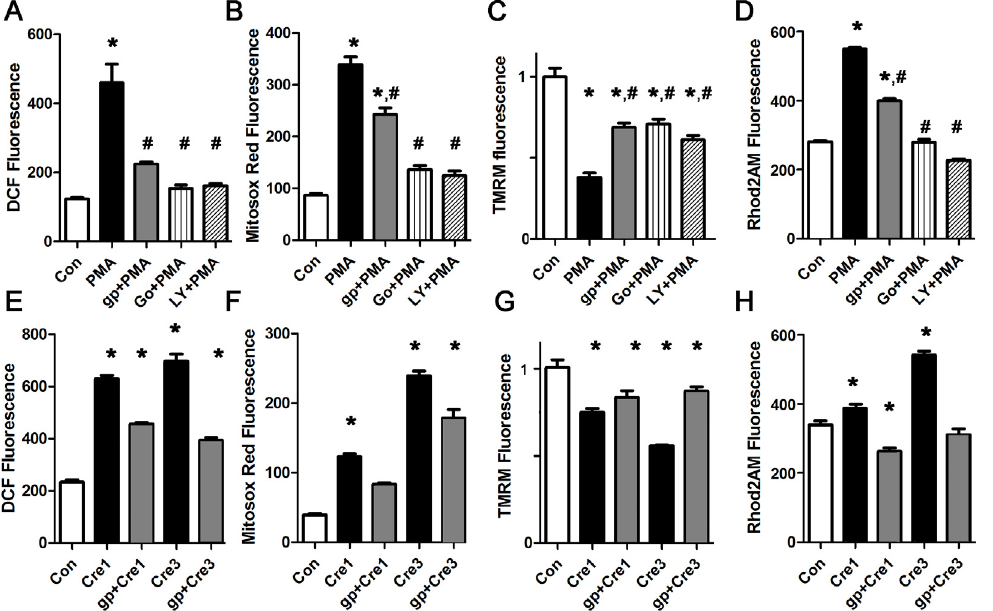
Fig 5. NOX2 inhibition reduces PMA-induced and cresol-induced ROS. A. Representative PMA experiment done with cardiomyocytes in triplicate, height is DCF fluorescence minus background, in live cells, expressed in arbitrary units, mean + SEM. B. PMA experiment using mitosox red signal. C. PMA experiment using TMRM signal. The NOX2 inhibitor and PKC inhibitors reduce depolarization. D. PMA experiment using Rhod2 signal. The NOX2 inhibitor and PKC inhibitors reduce calcium overload. E,F. Cresol increases total ROS and mitochondrial ROS. G. Cresol depolarized the mitochondrial inner membrane. H. Cresol increases mitochondrial calcium. For all panels, means are significantly different by ANOVA, * = sig different from control by post-hoc test, # = sig different from PMA by post-hoc test. PMA 100 nM, gp = gp91ds peptide 50 μ M, Go = Go6983 5 μ M, LY = LY333531 50 nM, Cre = cresol 1 or 3 μ